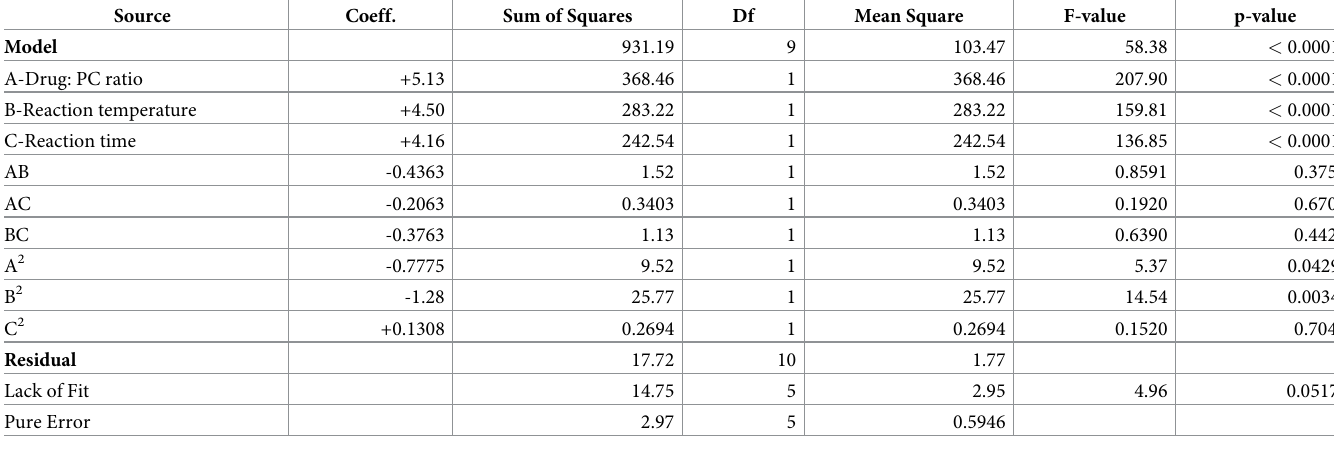
Table 3. ANOVA of the quadratic